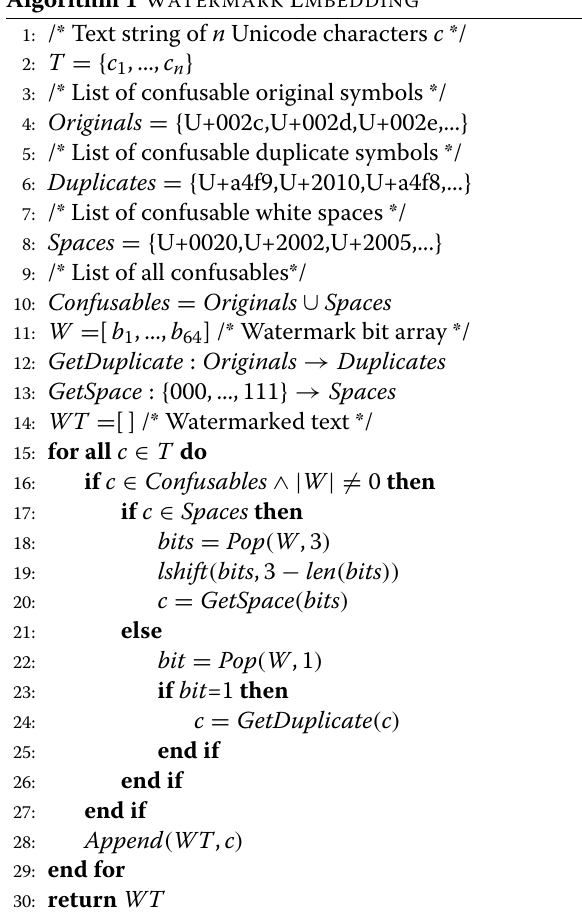
Algorithm 1 W ATERMARK E